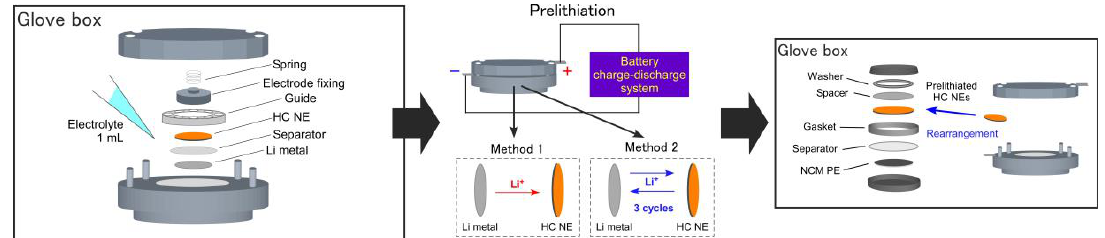
Figure 1. Processes of prelithiation for hard carbon (HC) negative electrodes (NEs) and lithium nickel cobalt manganese oxide (NCM)/HC full-cell assembly.